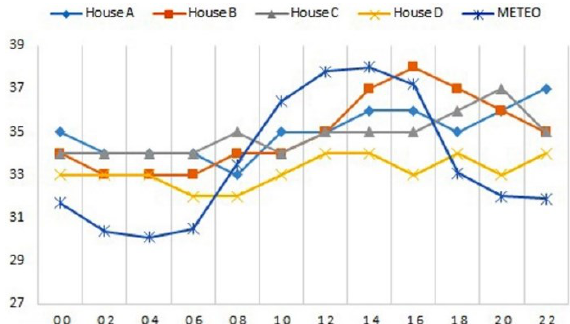
Figure 10. Comparison of temperature variation in 27th June 2019 between four temperature station and the meteorological station